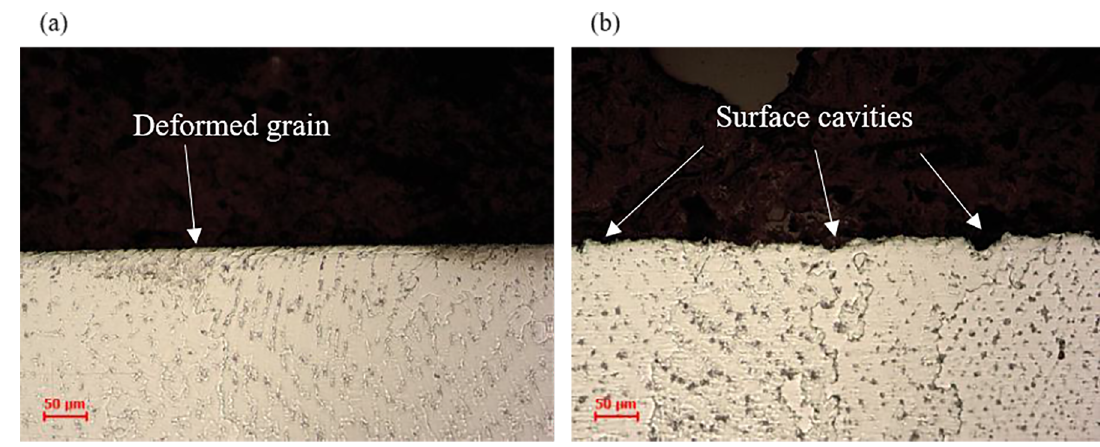
Figure 10. Metallographical cross-sections of the machined surfaces at cutting time (a) 1 min and (b) 3